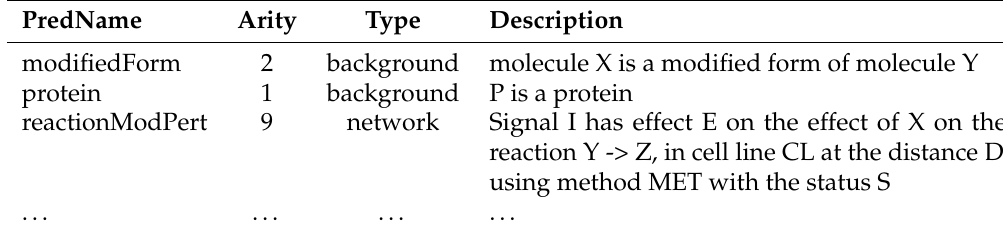
Table 6. The Predicate